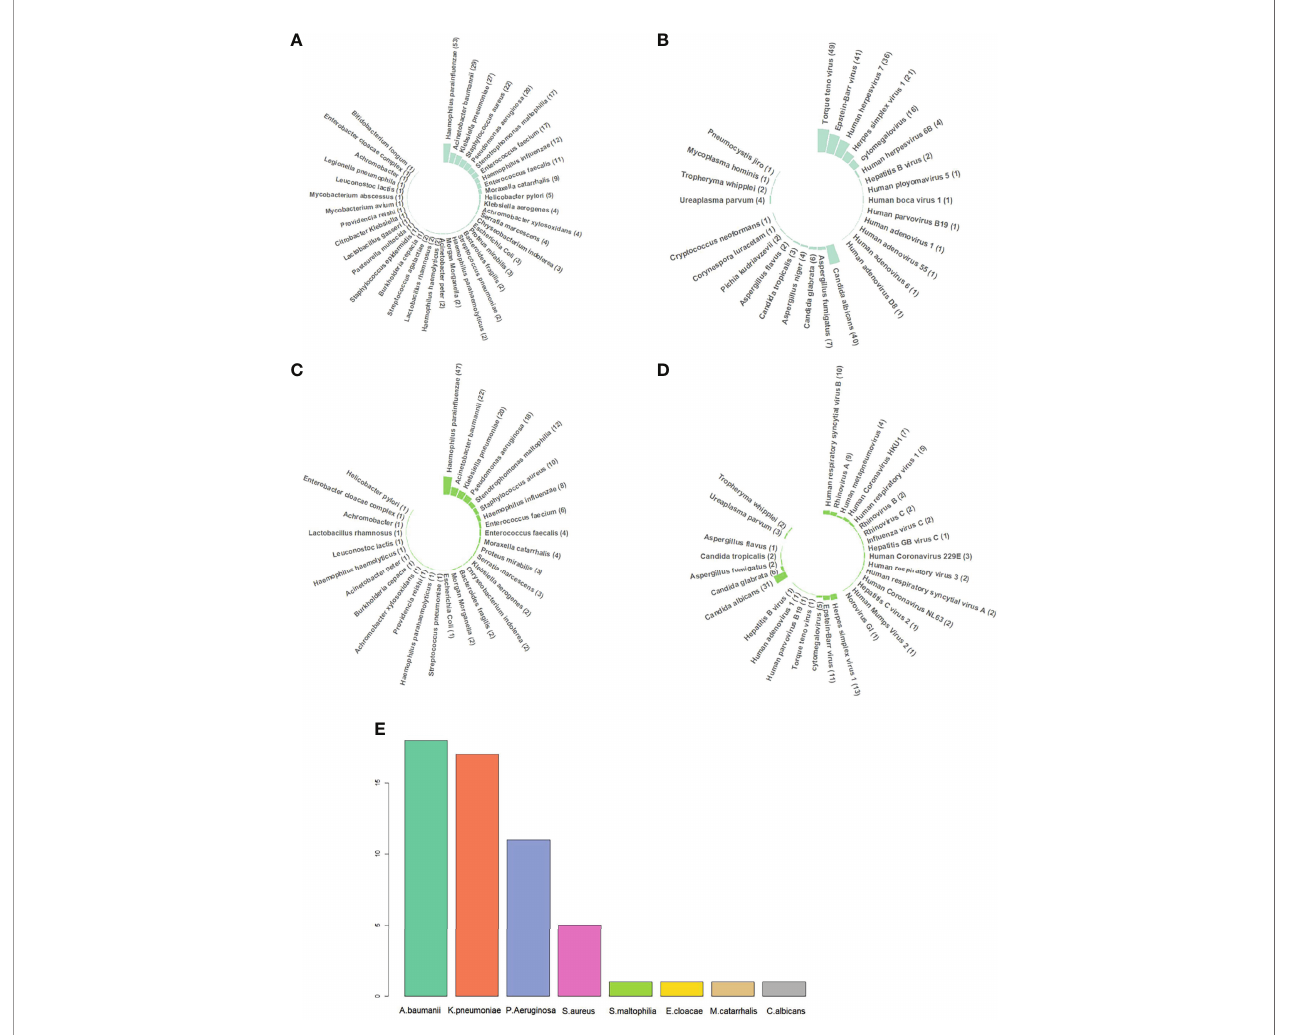
FIGURE 1 | Different pathogen species identi fi ed by metagenomic next-generation sequencing (mNGS) and culture. (A) DNA sequencing results of bacteria. Haemophilus parain fl uenzae , Haemophilus in fl uenzae , Enterococcus faecium , Enterococcus faecalis , Candida albicans , etc., were commonly categorized into normal respiratory microbiomes, but they can still cause infection in immunocompromised patients. Therefore, all the sequencing results were listed, including those of respiratory microbiomes. (B) DNA sequencing results of DNA viruses, fungi, and atypical pathogens. (C) RNA sequencing results of bacteria. RNA sequencing was performed on 112 out of 122 samples. (D) RNA sequencing results of RNA viruses, DNA viruses, fungi, and atypical pathogens. (E) Sputum culture results. H. parain fl uenzae , H. in fl uenzae , E. faecium , E. faecalis , and C. albicans were categorized into normal respiratory microbiomes when cultured. If H. in fl uenzae and C. albicans grew massively, they would be reported positive. Abbreviations: A. baumannii , Acinetobacter baumannii ; K. pneumoniae , Klebsiella pneumoniae ; P. Aeruginosa , Pseudomonas aeruginosa ; S. aureus , Staphylococcus aureus ; S. maltophilia , Stenotrophomonas maltophilia ; E. cloacae , Enterobacter cloacae ; M. catarrhalis , Moraxella catarrhalis ; C. albicans , Candida albicans